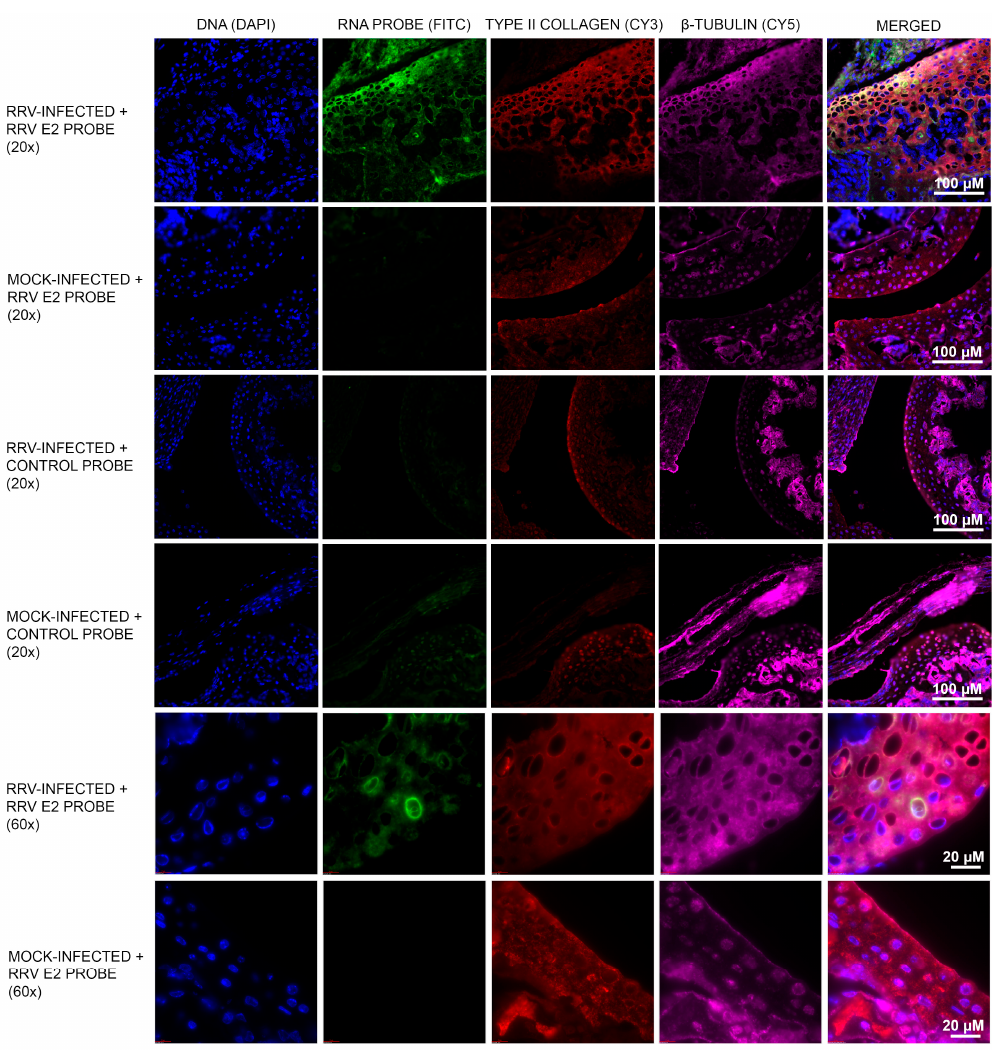
Figure 1. Murine chondrocyte cells are susceptible to Ross River virus (RRV) infection. Chondrocyte cells in the cartilage region of RRV-infected mice were stained positive for RRV envelope 2 (E2) RNA by fluorescence in situ hybridisation (green/FITC). To identify the chondrocyte cells, type II collagen immunostaining was performed to locate the cartilage region (red/Cy3). Tissue sections were also stained to better visualise cell morphology: DNA (blue/DAPI) and β -tubulin (magenta/Cy5). No FITC signal was observed in mock-infected mice. The experiment was also performed using a negative control probe to rule out any non-specific RNA probe binding. Images were captured at 20× and 60× magnifications.